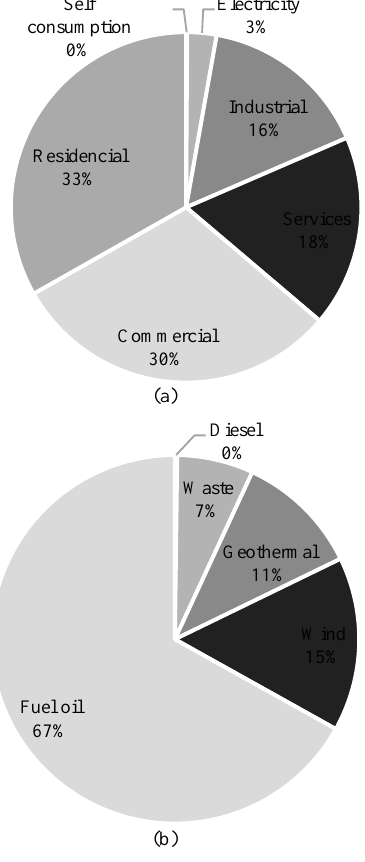
Fig. 1. Energy (a) consumption and (b) production in Terceira Island (2018)